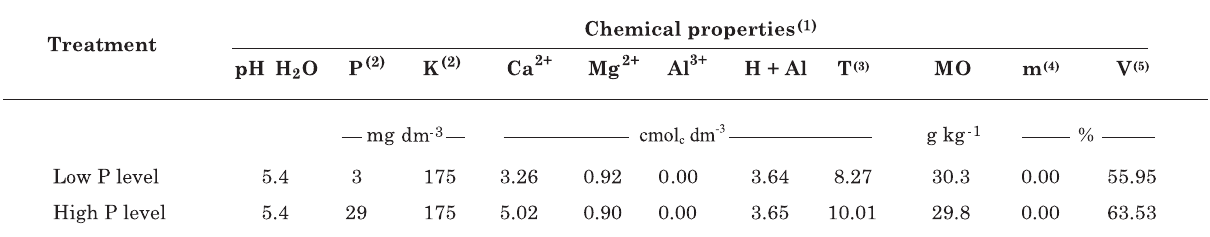
Table 1. Soil chemical properties after phosphorus